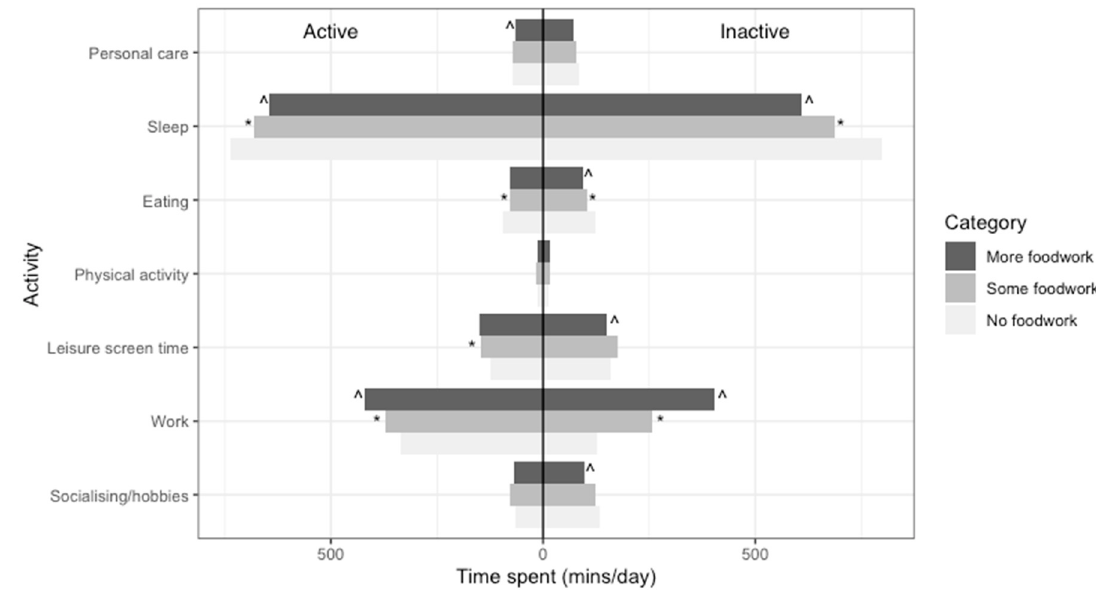
Figure 3. Model-adjusted a compositional means for economically active and inactive participants by foodwork category ( n = 6143) a Adjusted for age, gender, employment status, education, occupation, presence of children, and diary day type. ^ Statistically significant log-ratio difference between more and some foodwork for this part. * Statistically significant log-ratio difference between some and no foodwork for this part.